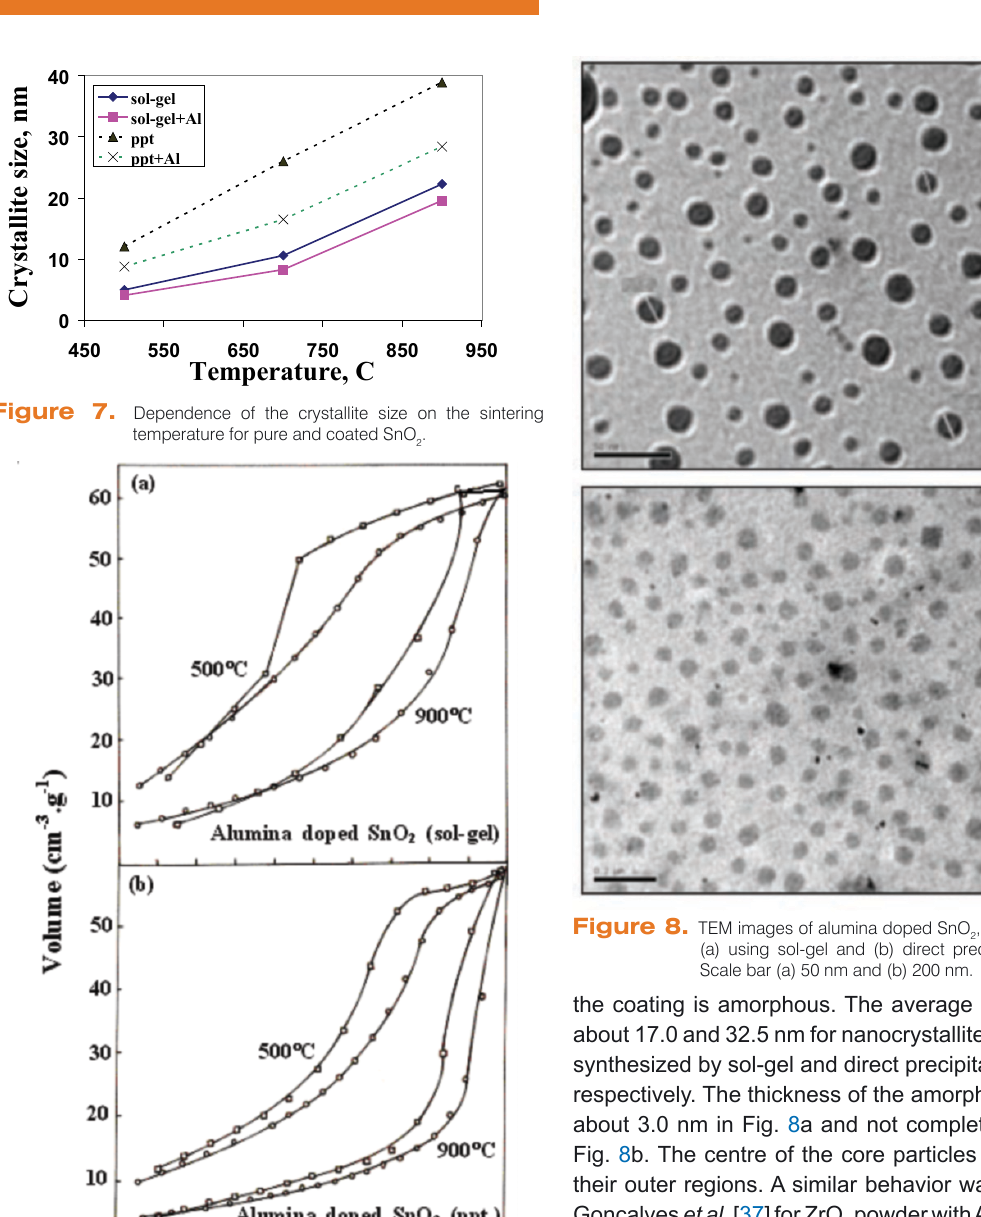
, calcined at 900°C: 2